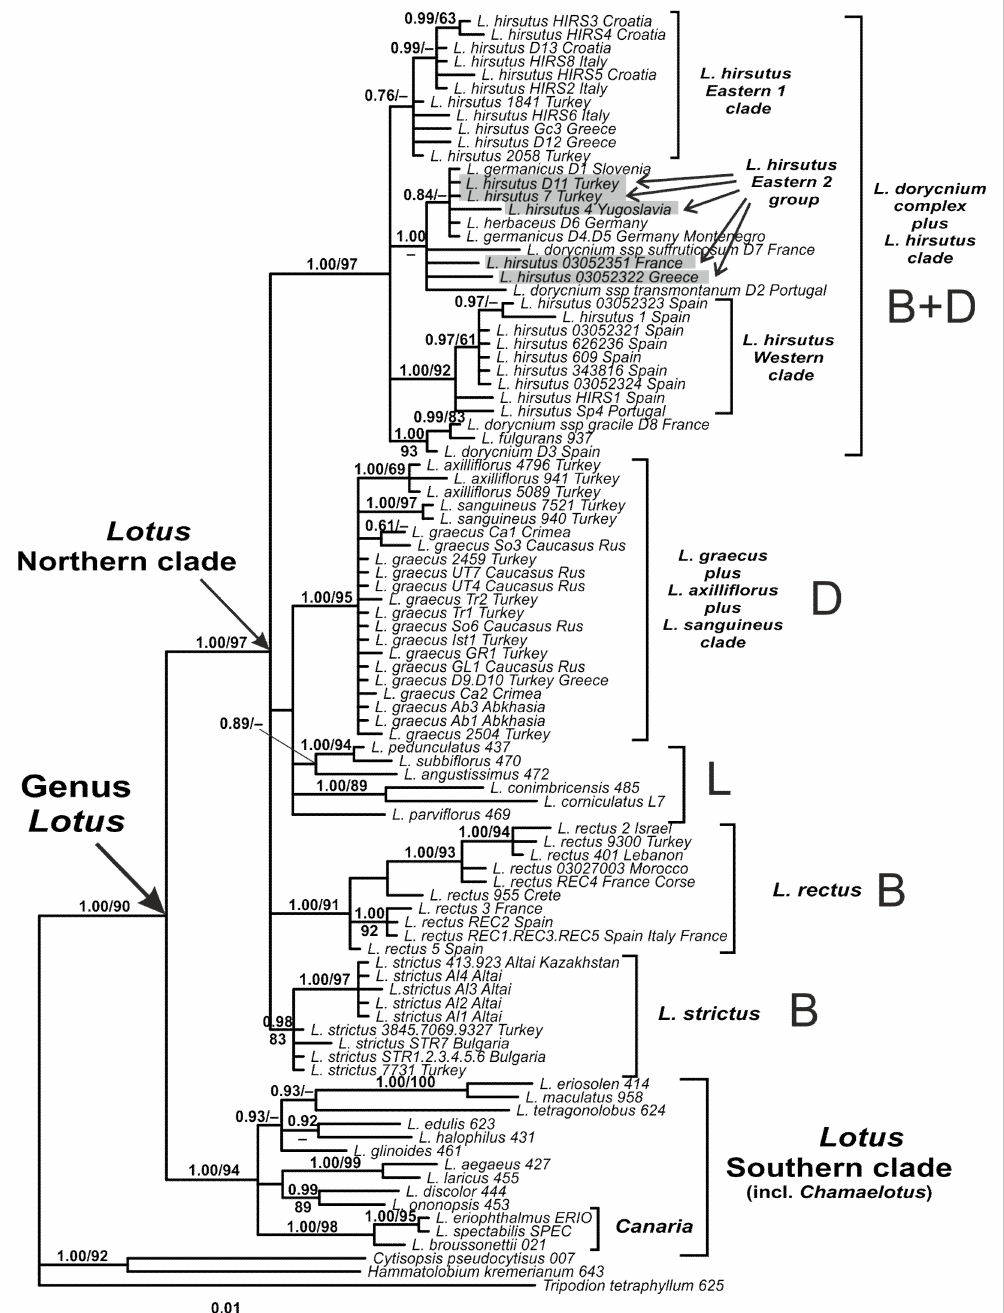
Figure 3. Phylogenetic relationships in Lotus inferred from Bayesian analysis of the plastid DNA dataset. Branch length is proportional to the number of expected nucleotide substitutions, scale bar corresponds to 0.01 substitutions per site. Numbers above branches are posterior probabilities. Numbers below branches or after slashes are bootstrap support values found in Maximum Likelihood analysis of the same dataset (values equal or more than 0.6/60% shown). Sections of the Northern evolutionary lineages of Lotus are marked as on Figure 1. Sample codes and country of origin for sequences are given after species names. See Appendix A for voucher